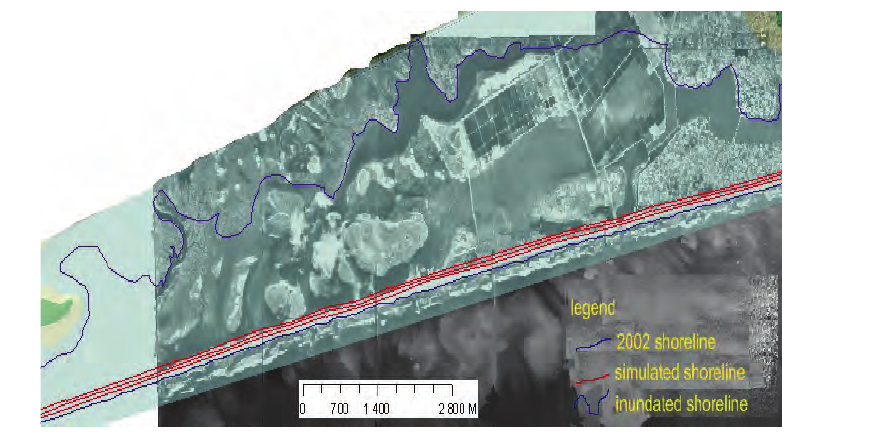
Figure 1. 20-year stage shoreline position in the western part of Accra